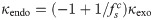
(a) Characteristic time ts and (b) relative saturation level fs in the (κendo, κexo) phase space. Single-hashed regions in panels (a) and (b) correspond to the values of κendo and κexo which result in ts or fs values experimentally observed for cluster-forming cells. (c) Double-hashed region shows the approximate extent of κendo and κexo rates in cell lines showing receptor clustering. The full circle represents the reference point (see text). (d) Similar to panel (c) but with different plot range. The solid line corresponds to the threshold line κendo=(-1+1/fsc)κexo, representing the unset of undetectable saturation level in experiments.